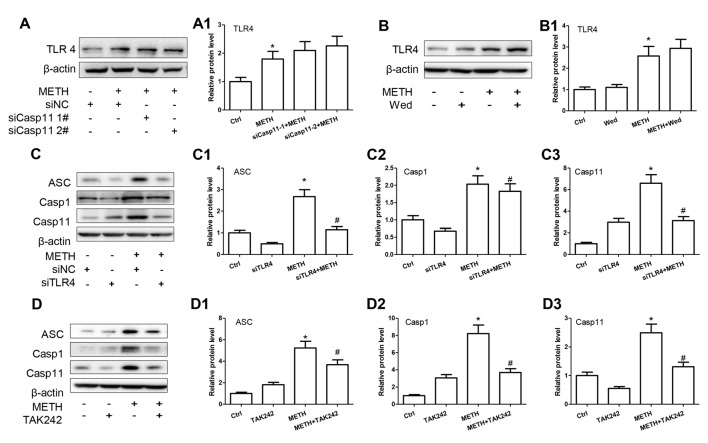
Caspase-11 is involved in TLR4-mediated IL-1β and IL-18 expression in METH-exposed astrocytes. Primary cultured astrocytes transfected with siRNAs targeting Caspase-11 (A,A1), TLR4 (C–C3) or control siRNA for 24 h followed by METH (2 mM) treatment for 24 h. Cells were exposed to Wed (30 μM) (B,B1) or TAK-242 (100 nM) (D–D3) for 2 h prior to METH (2 mM) treatment as indicated. Western blot (A–D) and quantitative analyses were performed to determine TLR4, Caspase-11, ASC and Caspase-1 protein expression. All the experiments were repeated three times. Data are expressed as mean ± SD. *p < 0.05 vs. non-METH-treated group. #p < 0.05 vs. the scrambled + METH treated group. Data in (A) were analyzed with two-way ANOVA followed by LSD post hoc analyses; data in (B–D) were analyzed with 2 × 2 factorial ANOVA followed by LSD post hoc analyses.